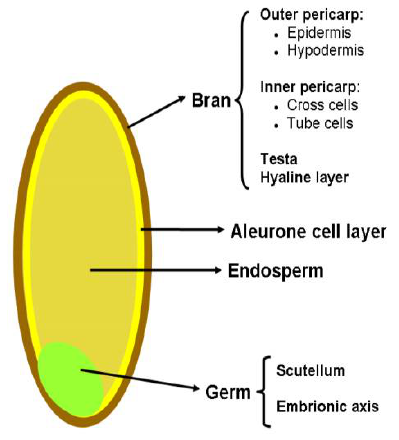
Figure 1. Caryopsis parts.